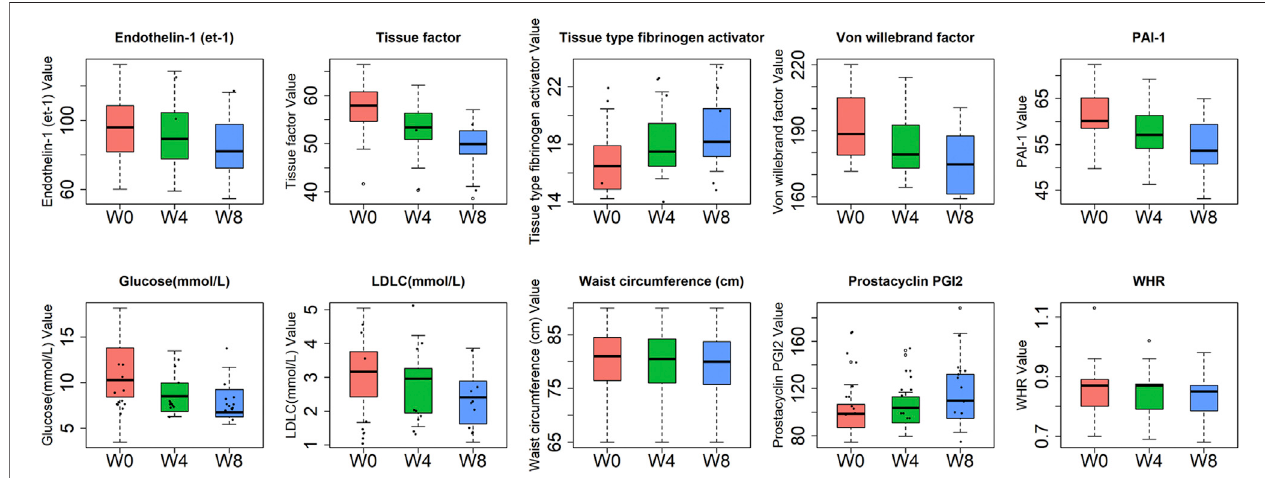
FIGURE 7 | Trends over time in clinical indicators with signi fi cant effects on gut microbes.